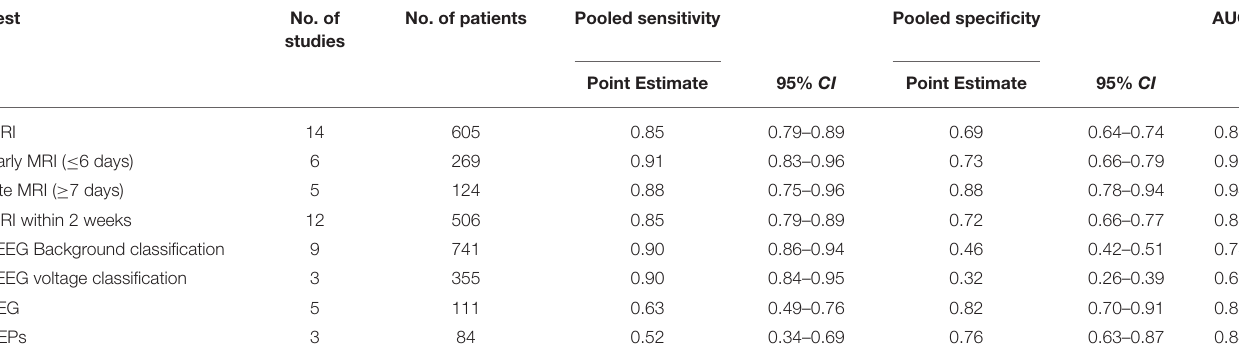
TABLE 3 | Pooled sensitivities and specificities with confidence intervals for tests where pooling was possible.